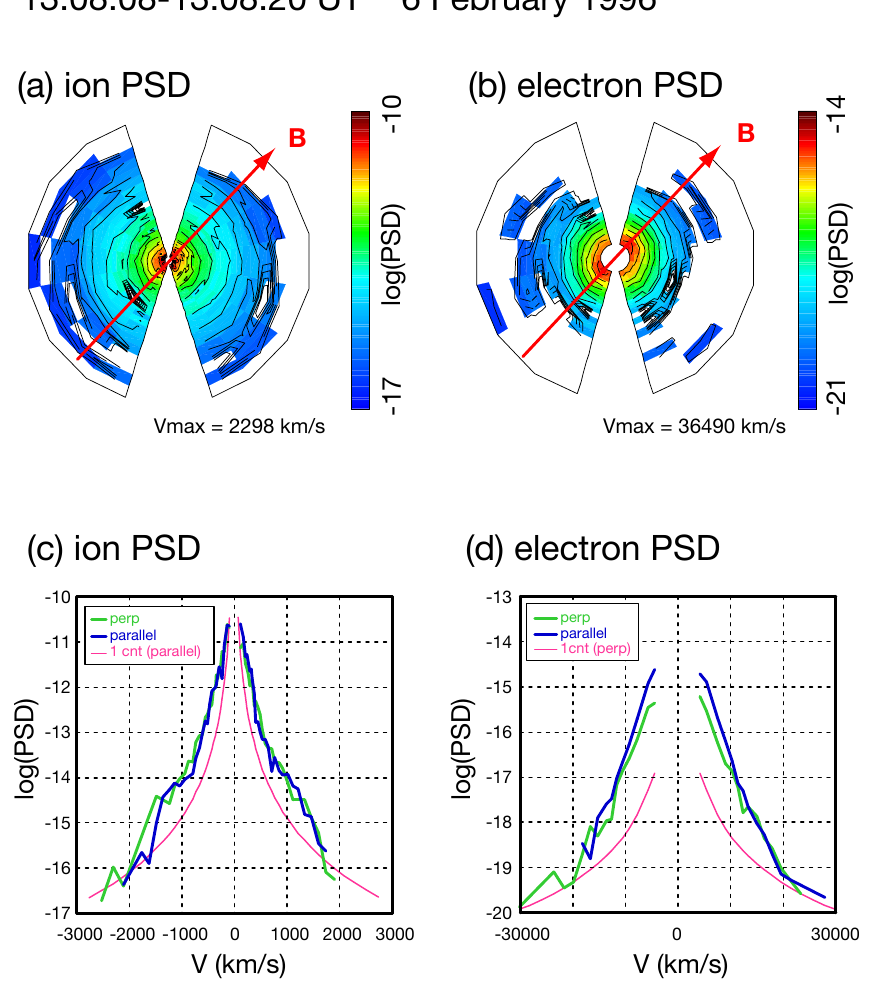
Fig. 5. Phase space densities of ions (a) and electrons (b) between 13:08:08–13:08:20 UT on 6 February 1996, in the plane that includes the local magnetic field. Panels (c) and (d) show 1-D cuts of ion and electron PSDs in the same format as Figs. 2c and d.